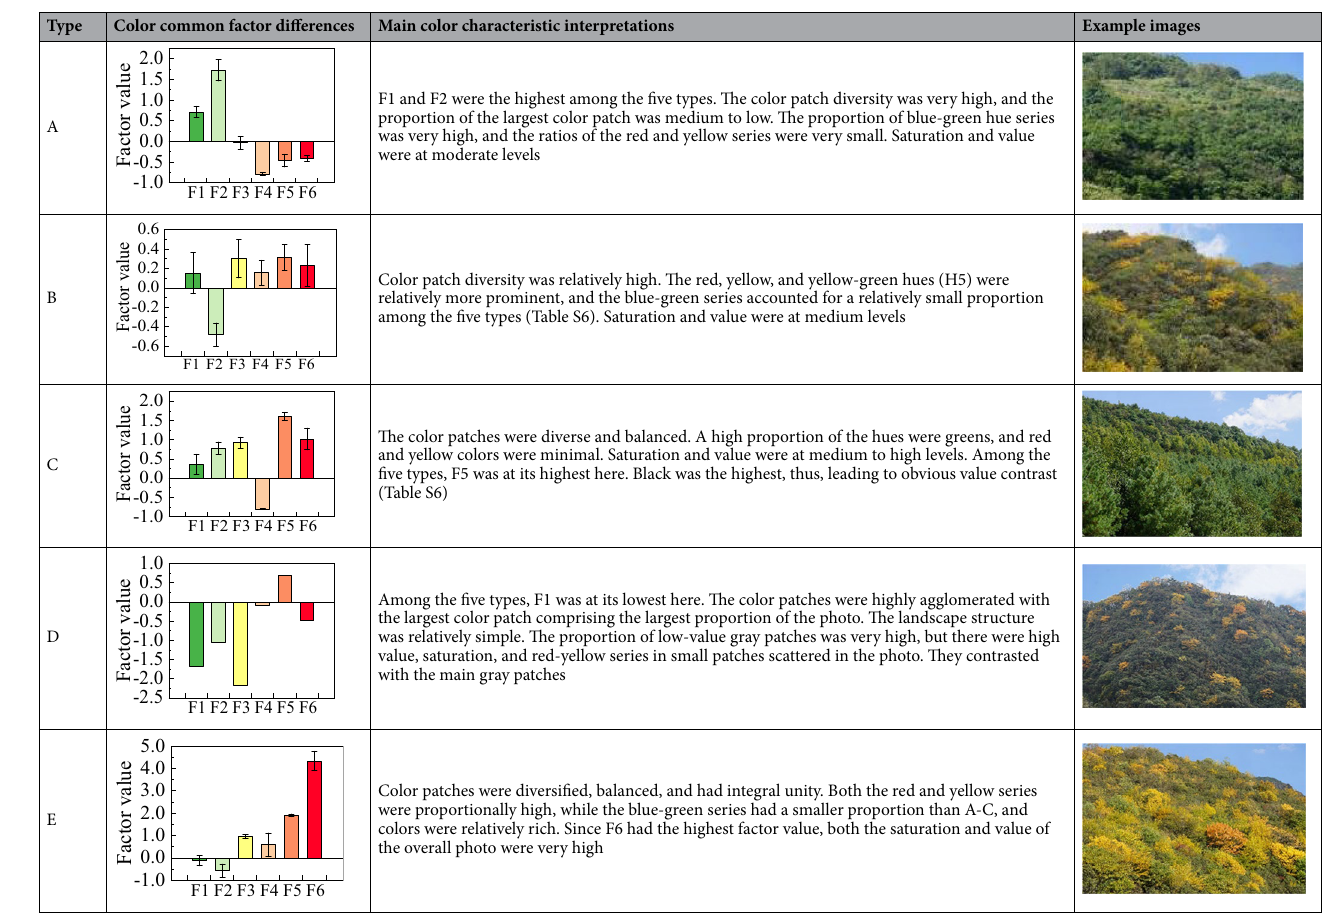
Table 2. Color combinations of the five superior visual aesthetic quality forest photo types (A–E). F1–F6, color common factors. Bars in the graphs indicate means, and whiskers indicate the SEs.